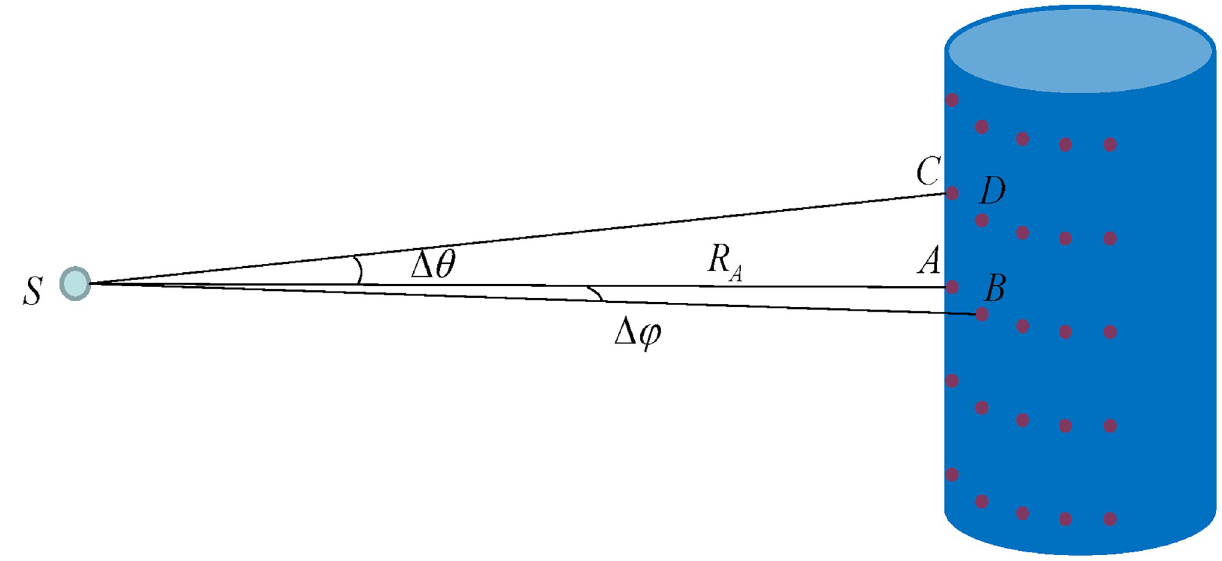
Fig 5. The geometrical working diagram of the BEE